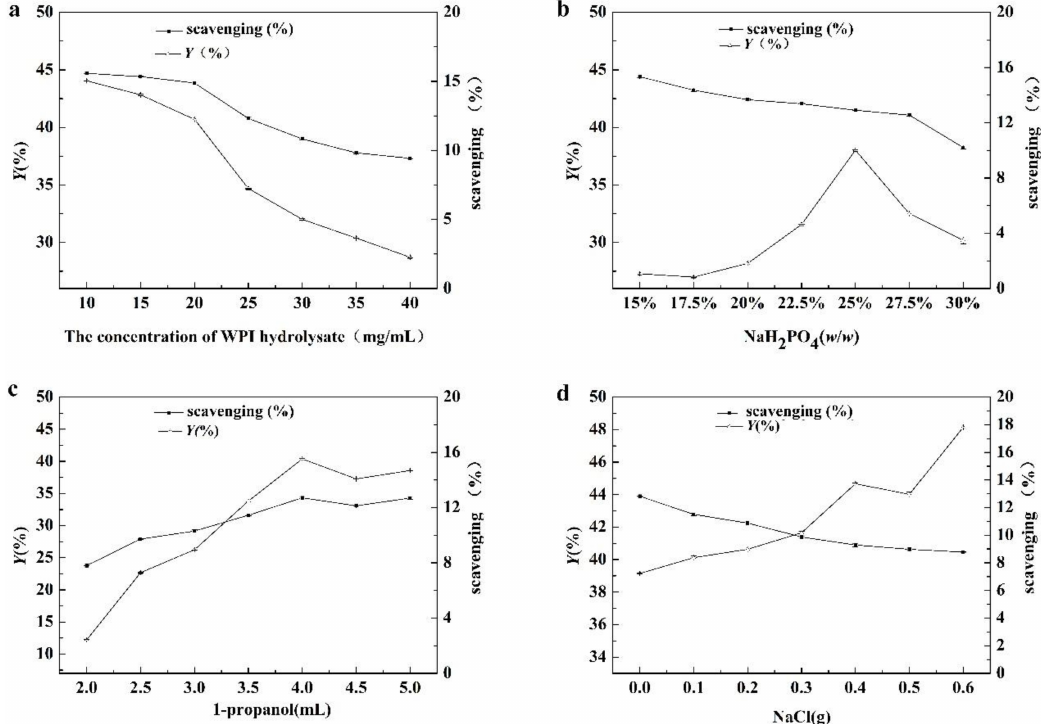
Figure 2. The effects of the concentration of ( a ) whey protein isolate (WPI) hydrolysate, ( b ) the mass fraction of NaH 2 PO 4 , ( c ) 1-propanol and ( d ) NaCl on the separation of antioxidant peptides. The scavenging was 2,2 (cid:48) -Azinobis-(3-ethylbenzthiazoline-6-sulphonate) (ABTS) free radical scavenging activity per unit concentration in top phase of Aqueous two-phase extraction